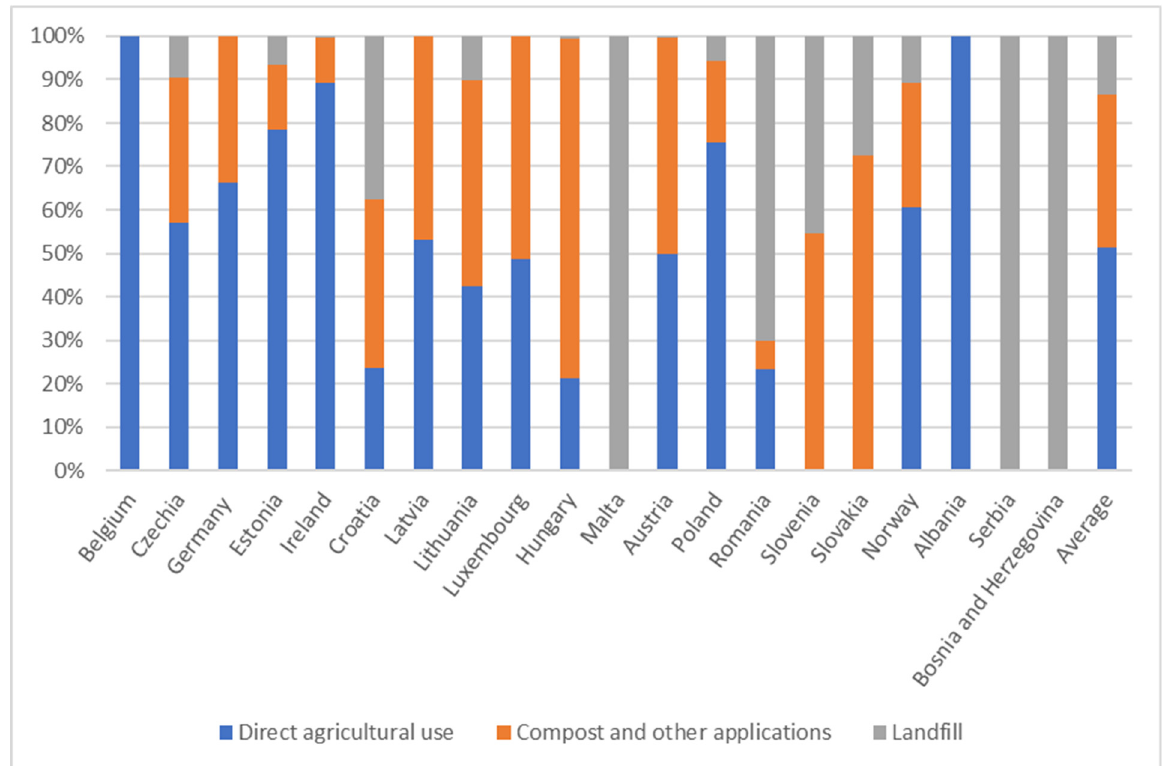
Figure 3. Sewage sludge disposal practices in selected EU member states (Eurostat data for 2019).